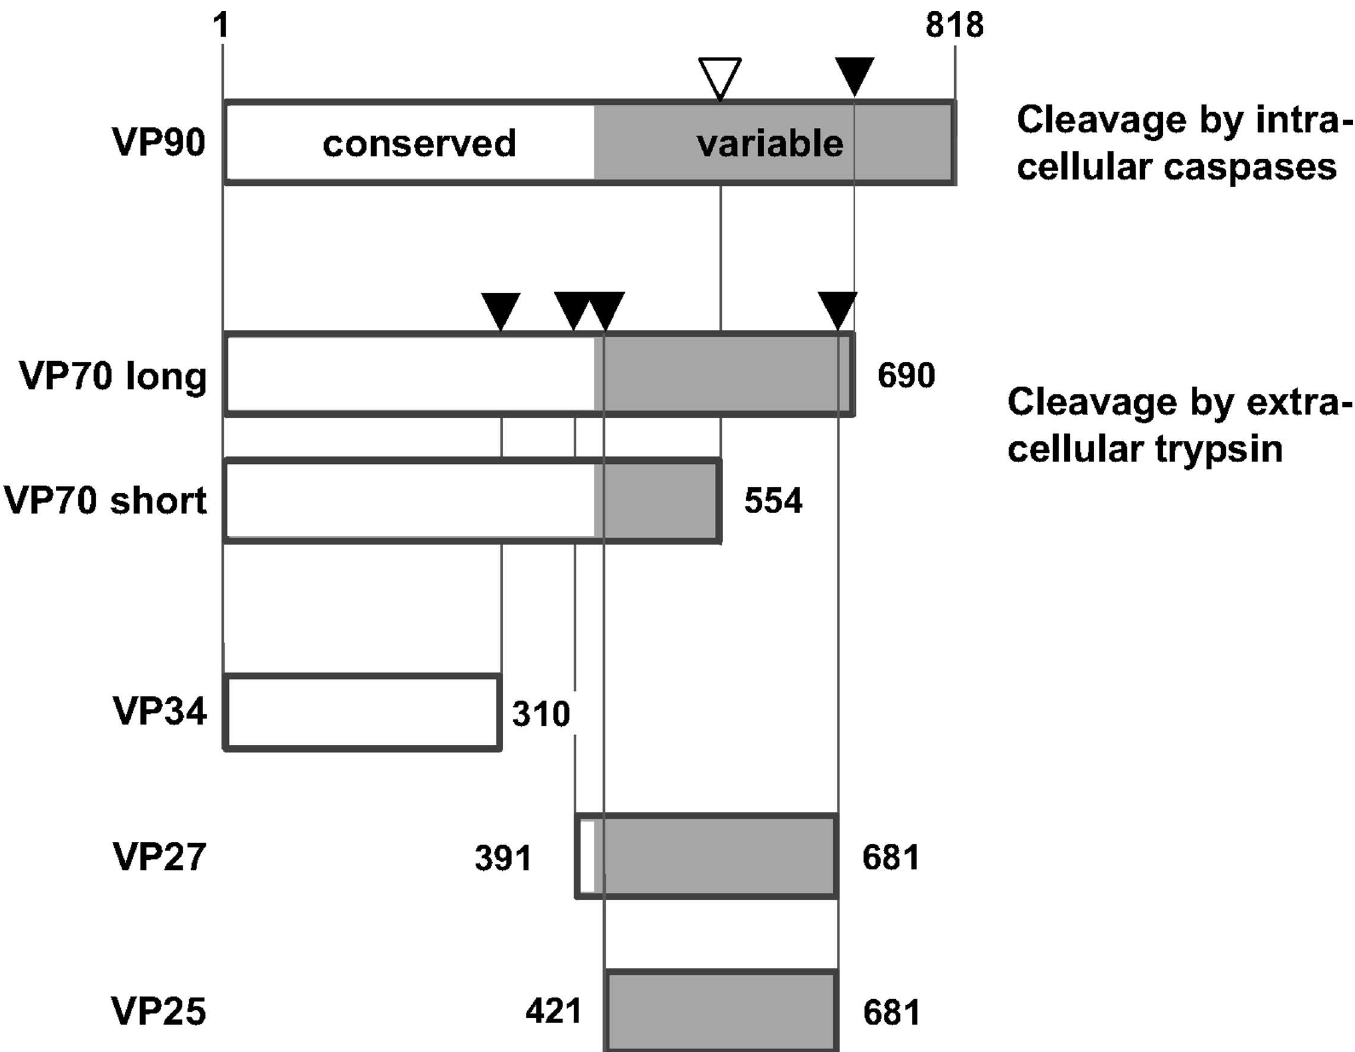
Fig 1. Schematic presentation of capsid processing as basis for the selection of amino acid sequences of MuAstV capsid proteins. The recombinant capsid proteins were used as antigens in multiplexMuAstV serology.VP70 long, VP34 and VP27 sequencefragments are based on processing data of humanastrovirus capsid protein accordingto UniProt ID O12792[24]. Cleavagesites are indicatedby black arrowheads. VP70 short fragment is basedon the predictedcaspase cleavagesite at aa position 554 as suggestedby Expasy Peptide Cutter (white arrowhead).The figure was adaptedfrom Krishna et al. [22] and modified by the